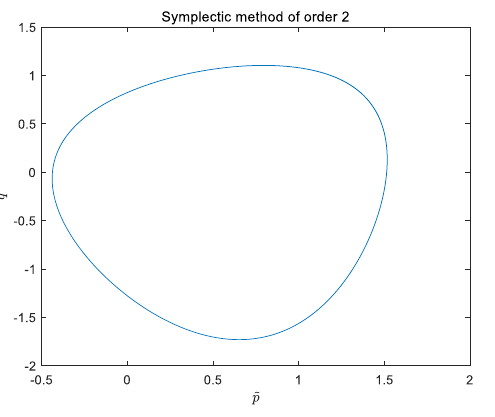
~ ,~ . Figure 1. Trajectory of the canonical variable (cid:101) p , (cid:101) q .